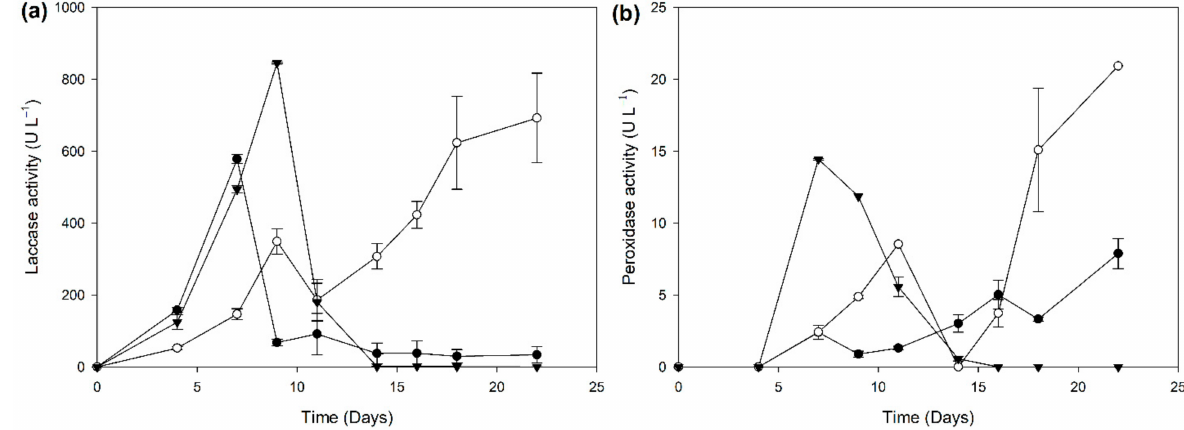
Figure 5. Laccase activity ( a ) and peroxidase activity ( b ) during the growth of P. citrinopileatus ( black circles ), A. biennis ( white circles ) and G. resinaceum ( black inverted triangles ), on CC.